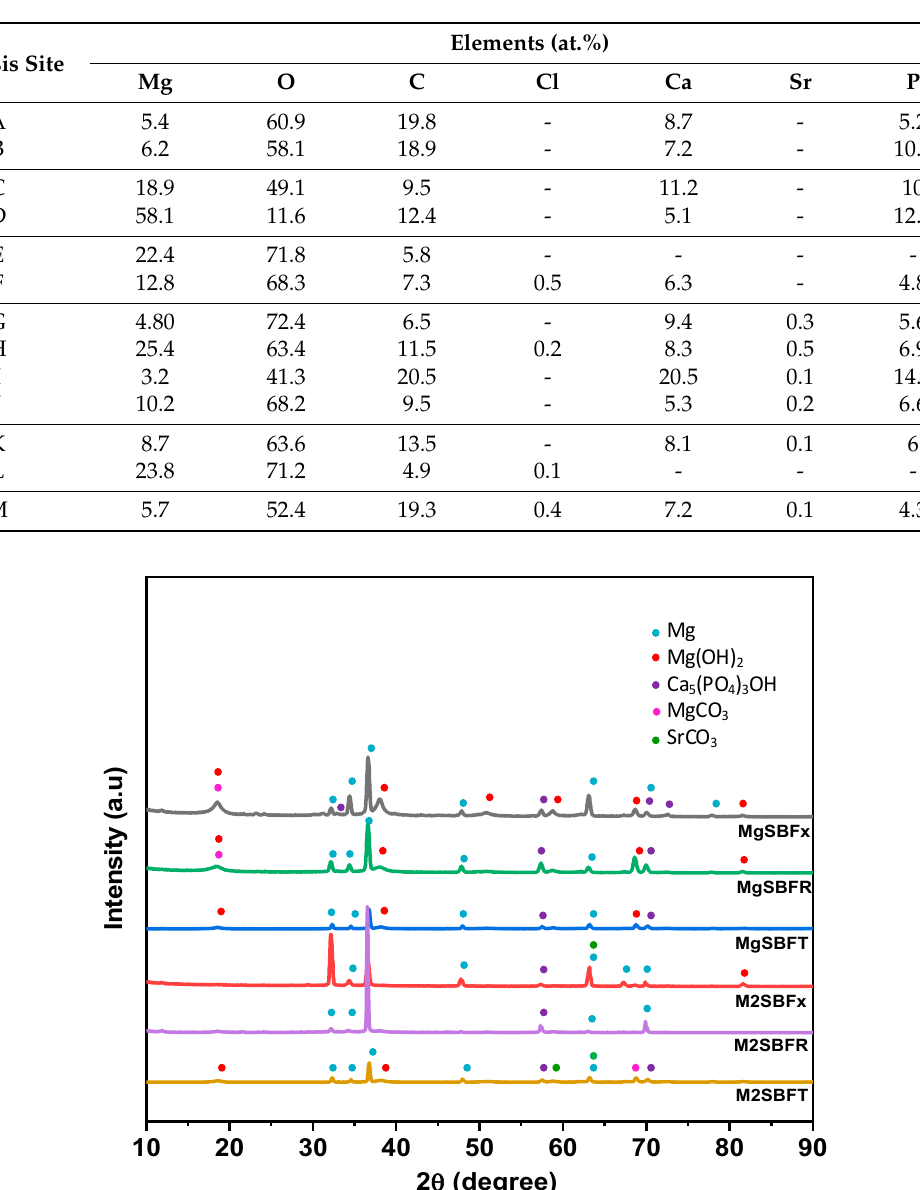
Table 5. Elemental composition of CP Mg and Mg-1.0Ca-0.5Sr alloy corrosion product via EDS analysis. Spots and area analysis (A–M) are indicated in Figure 4.